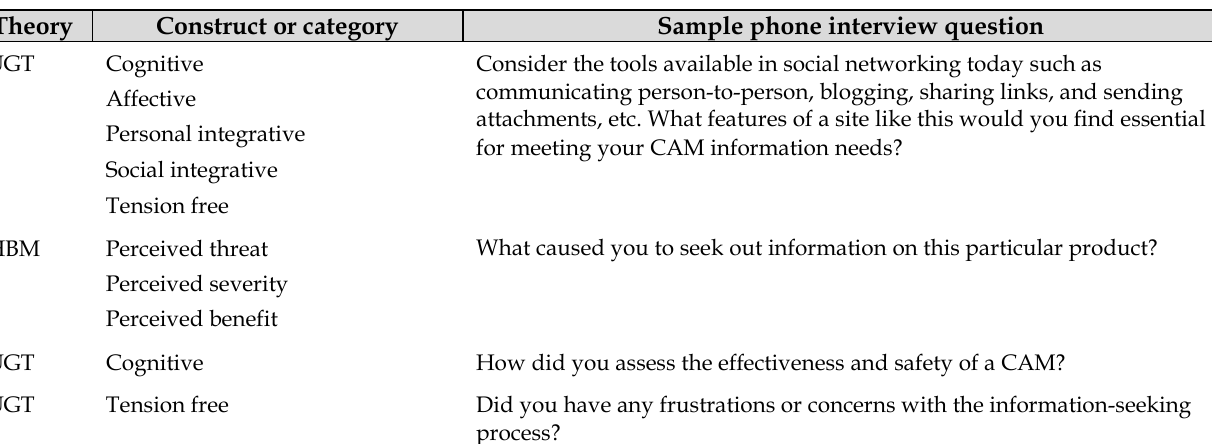
Table 2 Theories, constructs, and sample phone interview questions